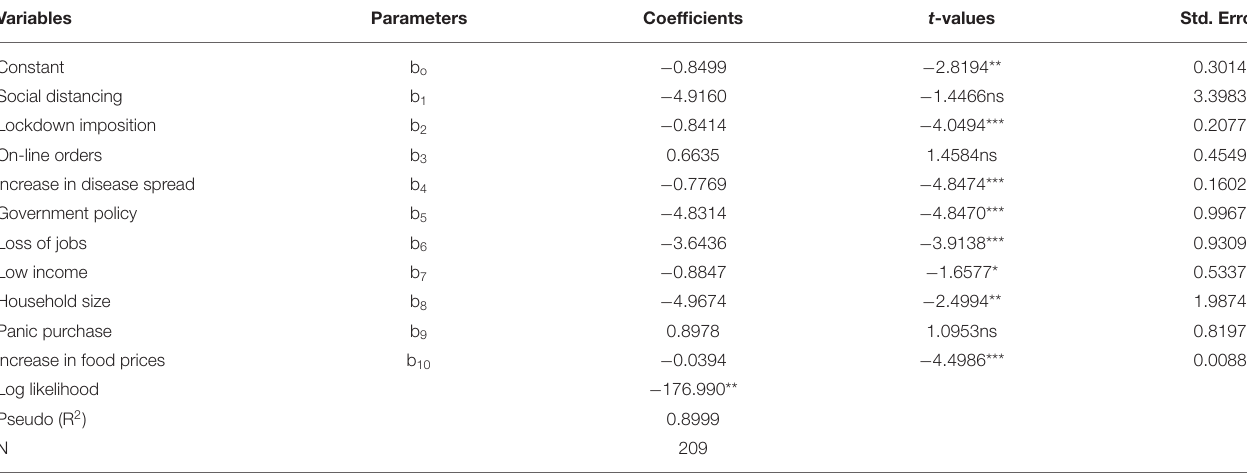
TABLE 7 | Estimated COVID-19 determinants of food security status of households in Southeast Nigeria. Variables